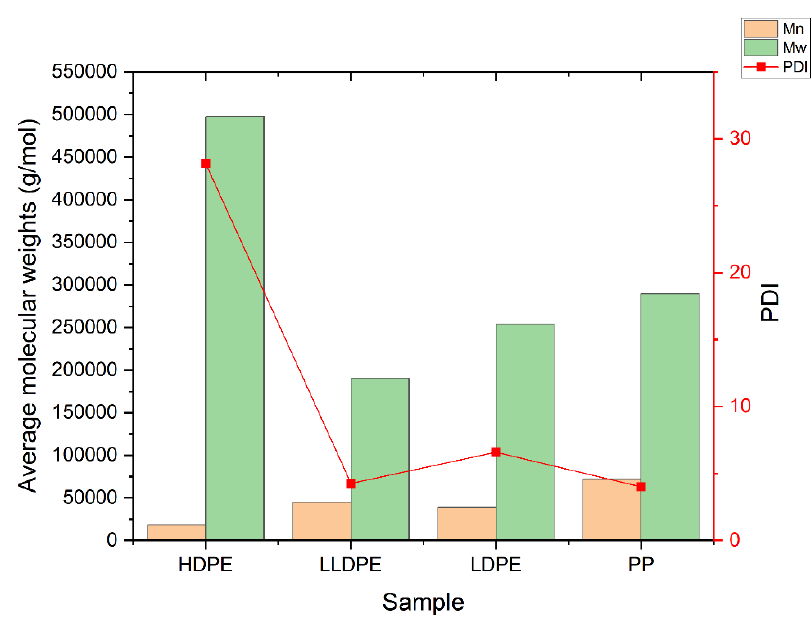
Figure 4. Molecular weights (M n , M w ) and PDI of PP, LDPE, LLDPE, and HDPE.